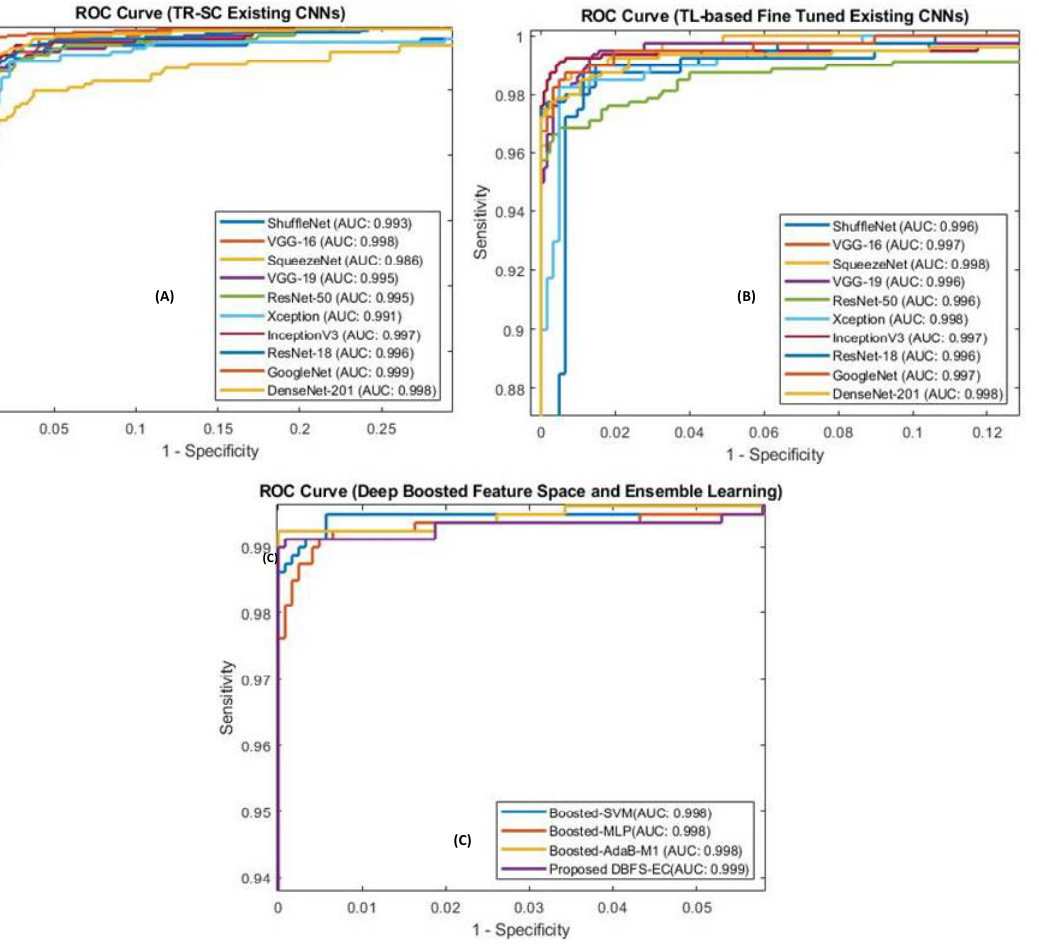
Figure 6. ROC curve for the existing CNNs, TR-SC based in ( A ), TL-B models in ( B ), and ( C ) represent proposed (DBFS-EC) framework.